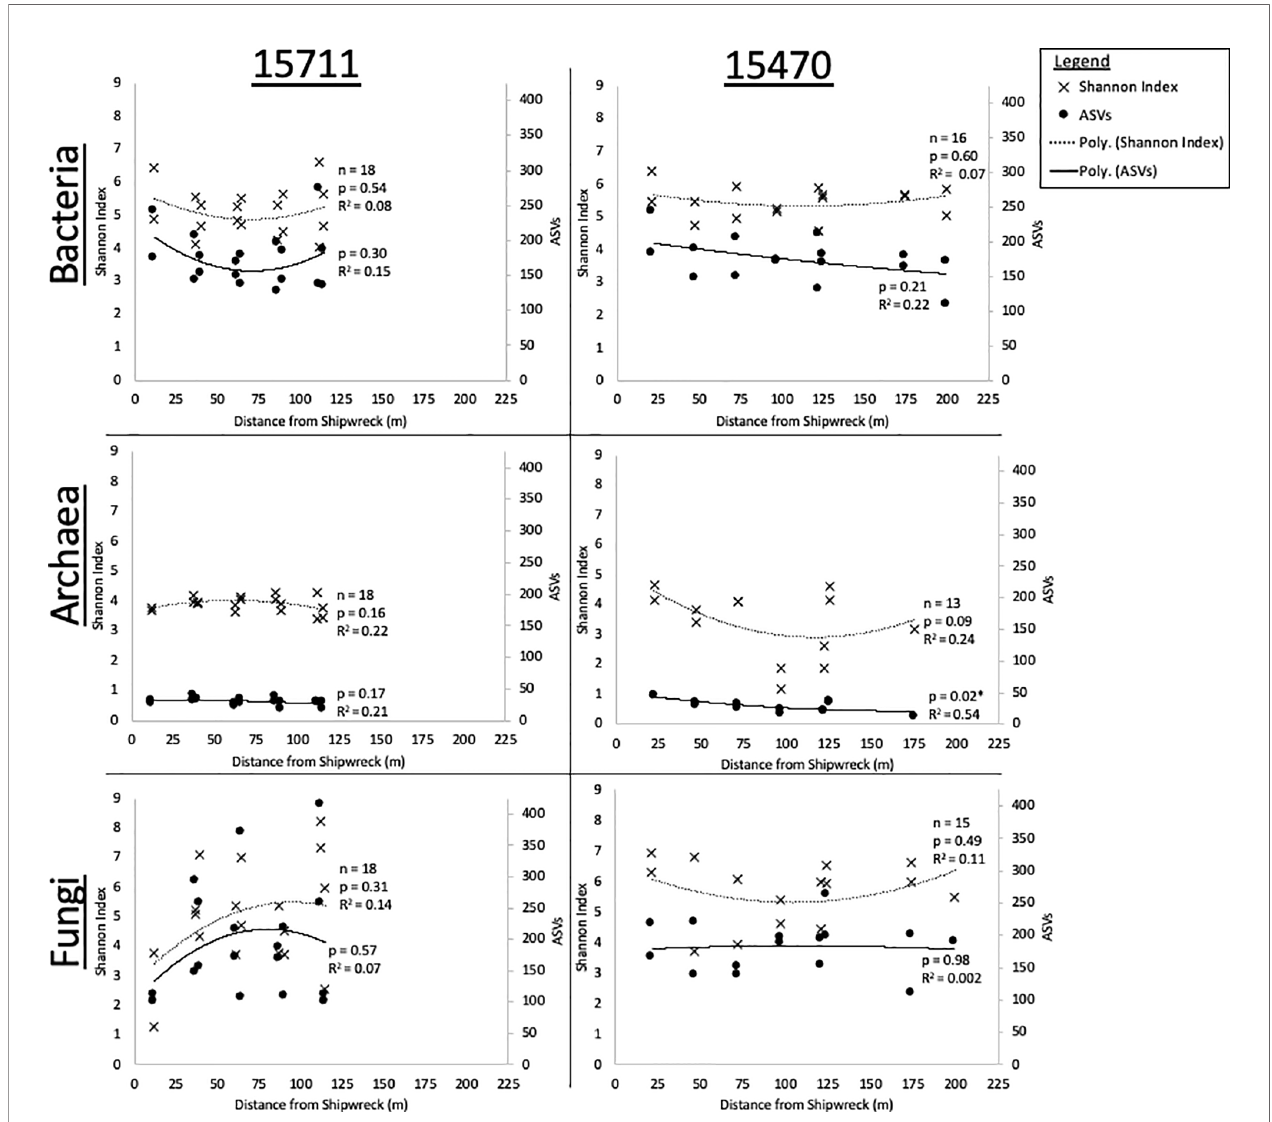
FIGURE 2 | Shannon Diversity and ASV Richness plotted as a function of distance for each site and each domain with replicates averaged. Signi fi cance (p < 0.05) of polynomial regression indicated by